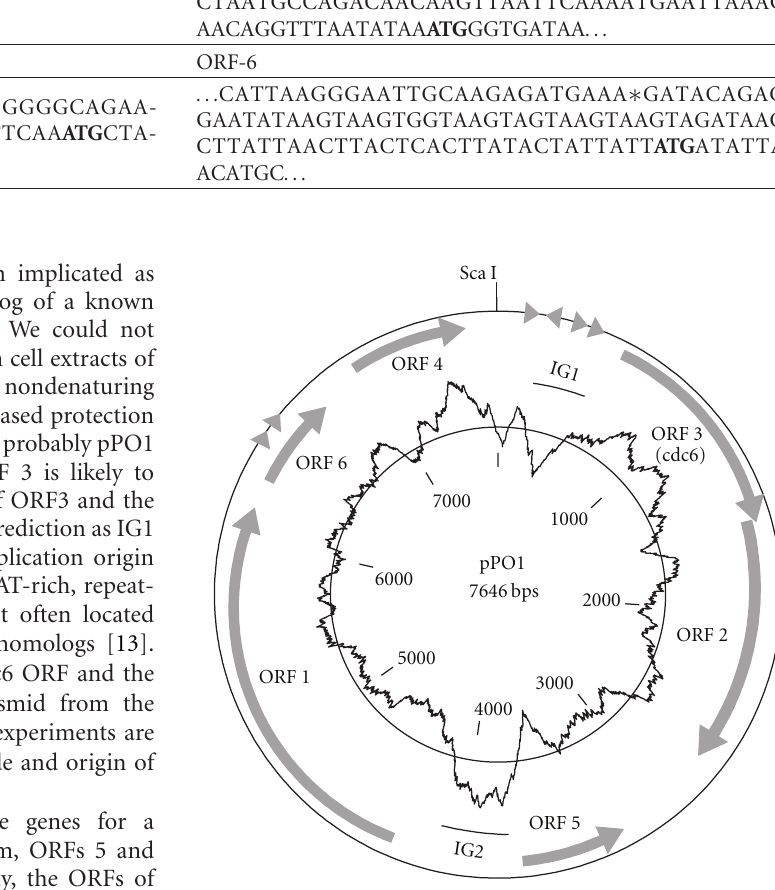
Figure 1: Schematic map of the pPO1 plasmid. Arrows designate ORFs, repeats are marked as triangles, and deviation from the average GC-content is plotted on the inner